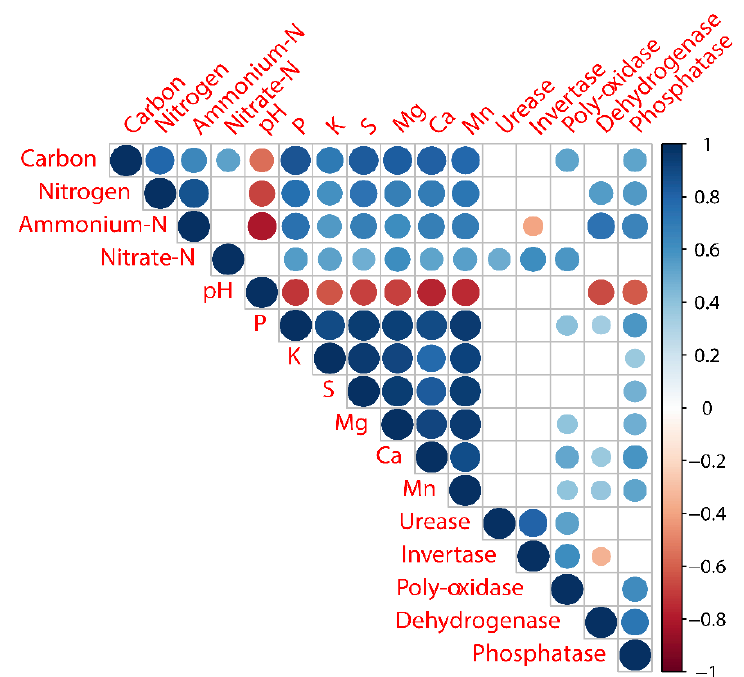
Figure 6. Pearson’s correlation of soil properties and enzymatic activities of the dominant tree species PK between PAPF, BPF and TPF in northeastern China. The significant ( p < 0.05) positive (blue color) or negative (red color) correlations are indicated by colors and circle sizes, while no significant correlations are omitted. Acronym’s definitions are as defined in Table 1.